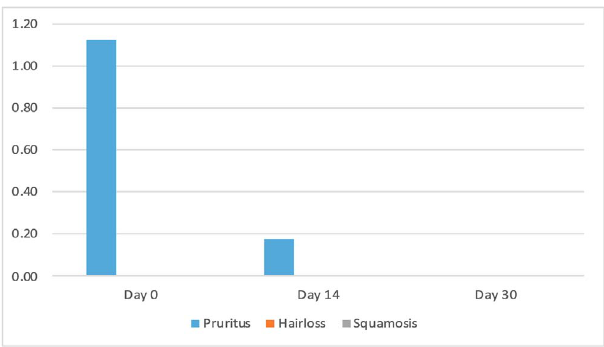
Figure 9. Average score for clinical signs associated with lice in cats from Group 2 (Frontline Combo (cid:1)